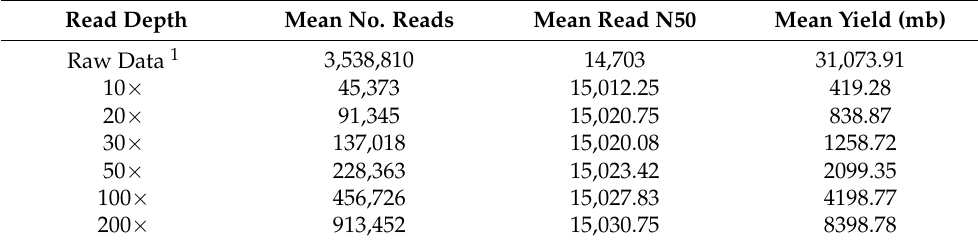
Table 2. Subsample statistics for each read depth. Each read depth had 12 subsamples. Read Depth Mean No.